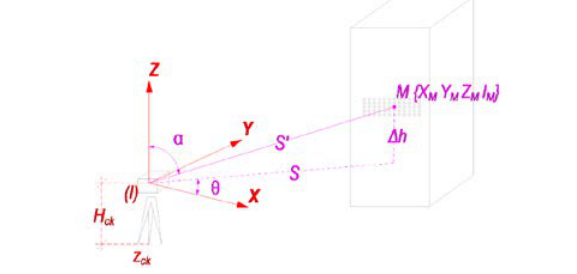
Figure 1. Coordinate positioning of scanned points Each point is determined by its spatial coordinates X, Y, Z and the intensity of the reflected signal l . The terrestrial laser scanner sends laser pulses to the object and receives the reflected signal (figure 1). The coordinate system of the scanner for the coordinates of each scanned point M